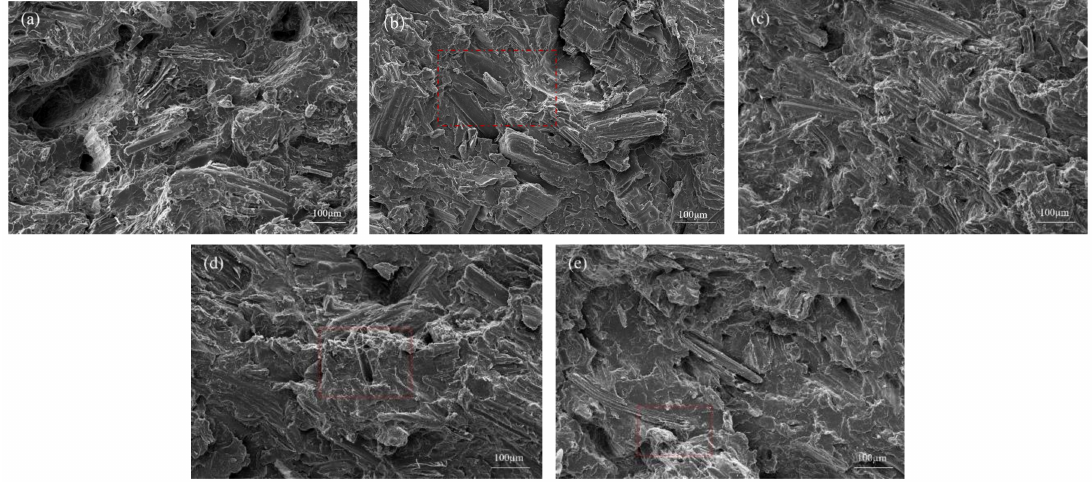
Figure 5. SEM micrographs of the impact cross-section of the BF/PLA: ( a ) UB/PLA; ( b ) DB/PLA; ( c ) ADB4/PLA; ( d ) ADB6/PLA; ( e )